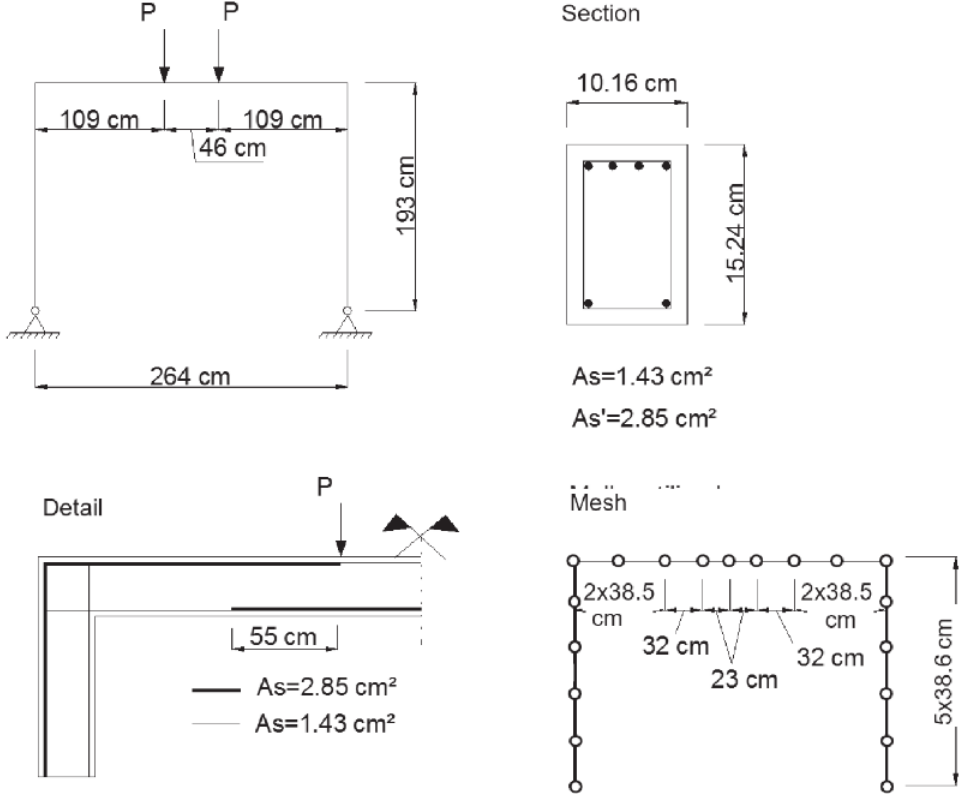
Tested frame (P2) geometry and reinforcement; load application; support positions and mesh used in numerical analysis (Cranston apud Bazant et al.